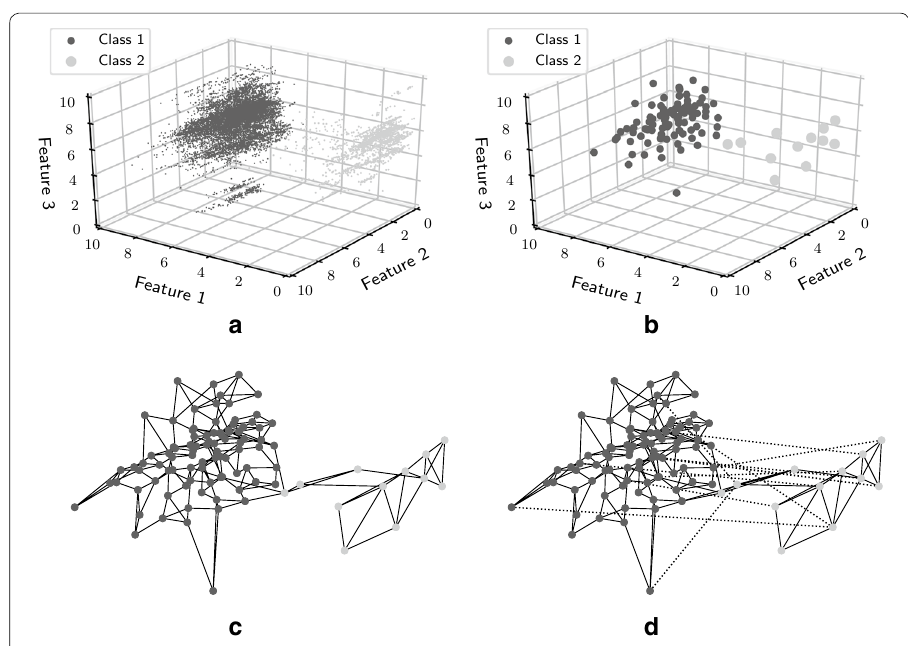
Fig. 6 Graph knitting procedure. Scaled UCI dataset, clustered data, constructed graph with no and 1 ENS iteration in a – d , respectively. Dashed edges in d are formed after ENS procedure